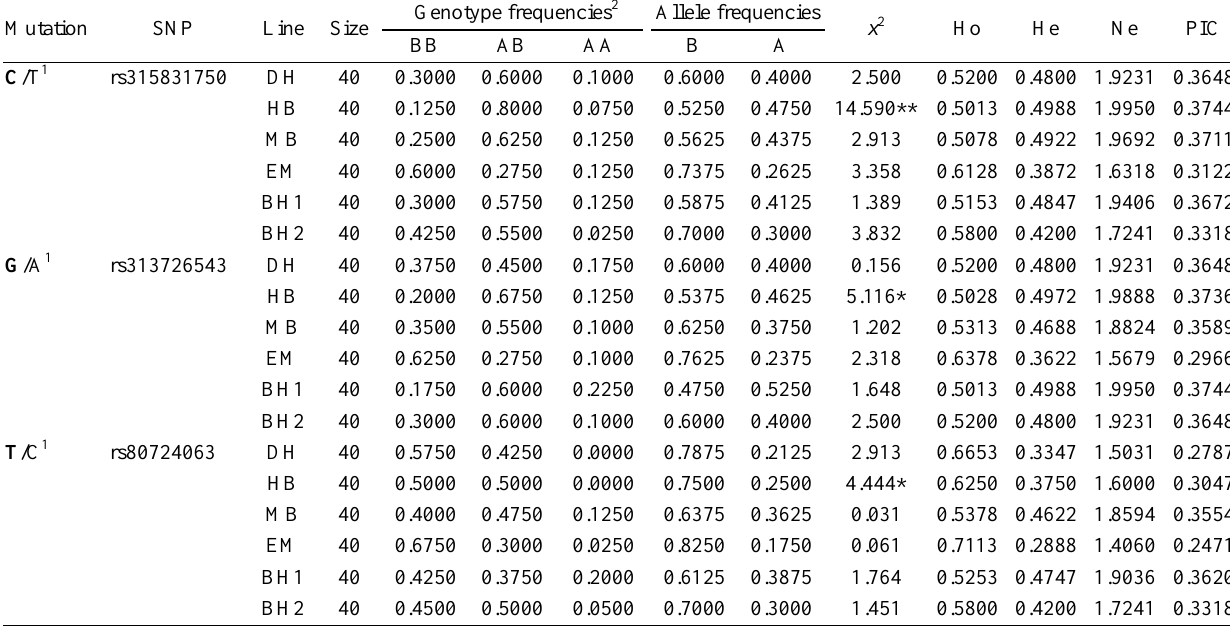
Table 3. Genotype and allele frequencies and genetic diversity parameters for the PLIN1 gene in six breeds Genotype frequencies 2 Mutation SNP Line Size